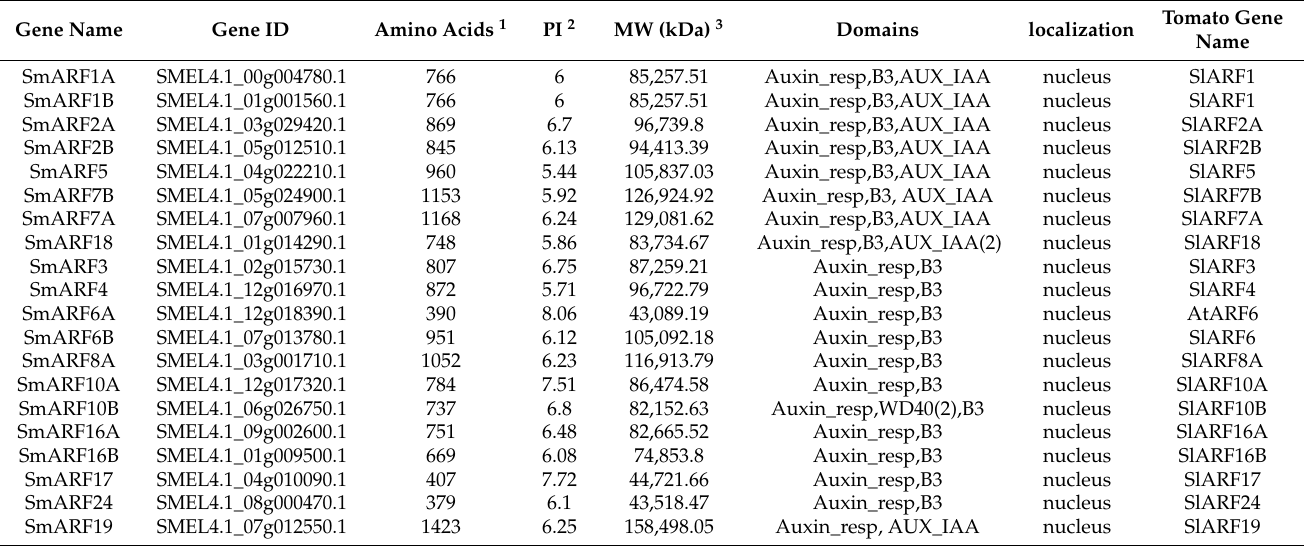
Table 1. Characteristics of putative genes encoding auxin response factors in Solanum melongena